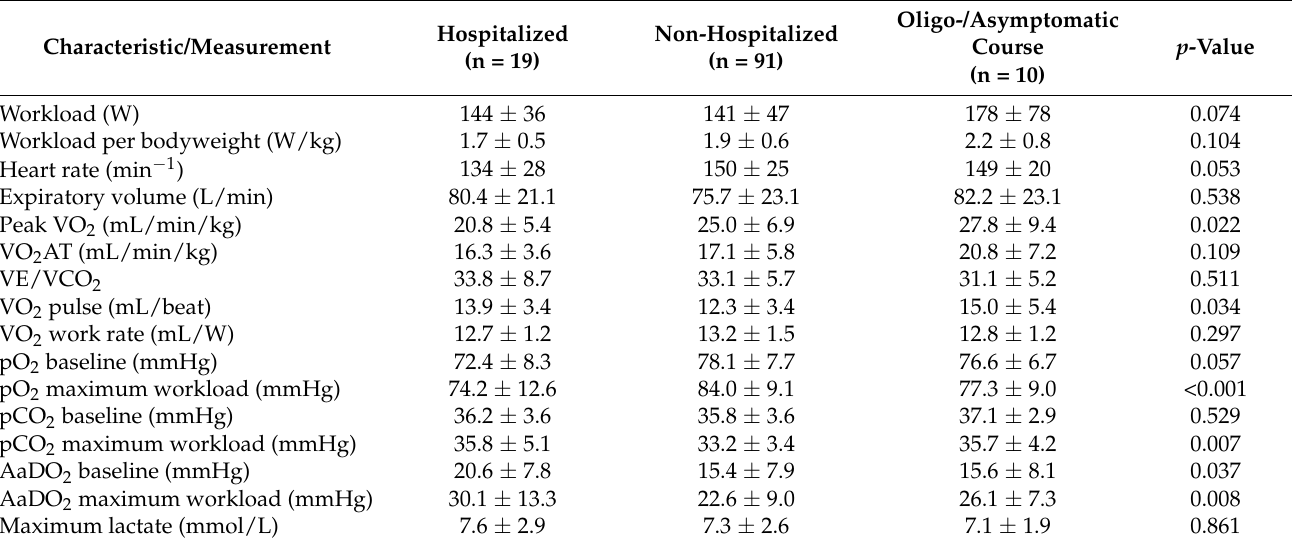
Table 3. Cardiopulmonary exercise testing depending on initial disease severity, divided into hospi- talized patients, non-hospitalized patients, and oligo-/asymptomatic